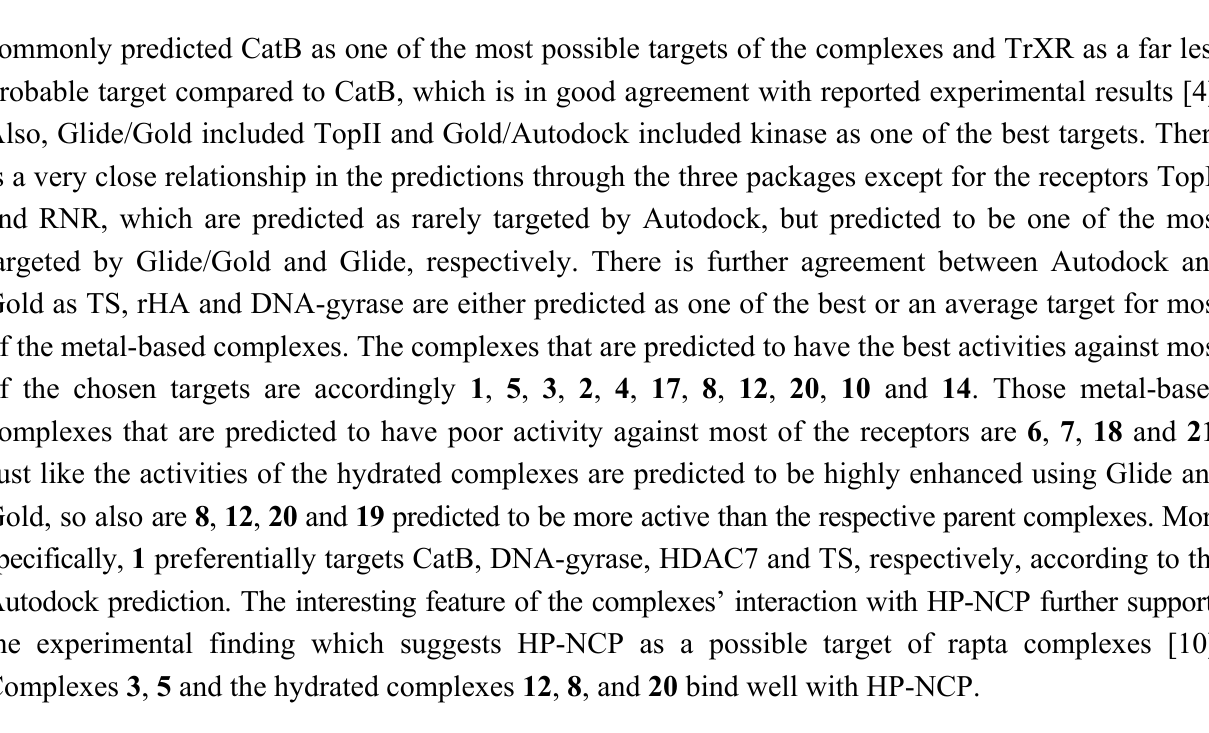
Table 4. The docking prediction for metal-based complexes using Autodock.